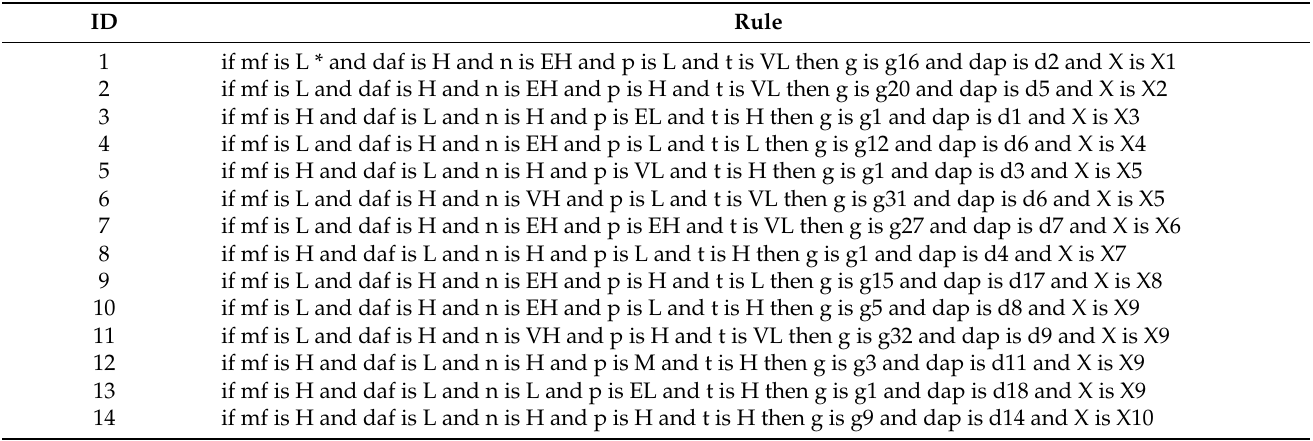
Table 5. Fuzzy rule base of developed FLClass